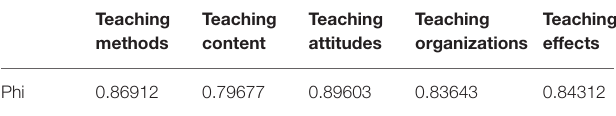
TABLE 6 | Dependability index from D study.